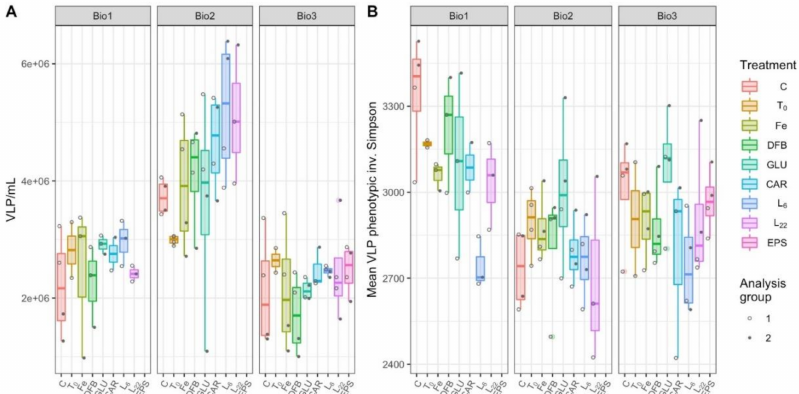
Figure 6. Virus-like particles (VLP) concentrations ( A ) and phenotypic biodiversity ( B ) during incubations with di ff erent treatments performed at each station (Bio 1–3). The treatments presented are: Ctrl (control, no Fe enrichment), Fe (inorganic Fe addition, FeCl 3 ), DFB (desferrioxamine B), GLU (glucuronic acid), CAR (carrageenan), L 6 (bacterial exopolymeric substance (EPS)), L 22 (bacterial EPS). Each point in panel B represents the mean of 100 bootstrapped iterations of FCM events randomly downsampled to the lowest count of events per